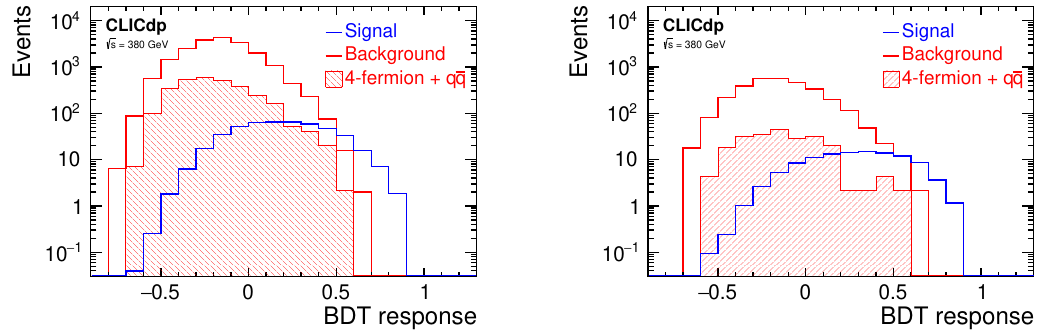
Figure 29. Response distribution of the BDT classi(cid:12)er used for the (cid:12)nal t ! cH event selection at p s = 380 GeV, for hadronic (left) and semi-leptonic (right) event samples. The total background (red histogram) is normalised to 1.0 ab (cid:0) 1 while the signal (events with a FCNC top quark decay; blue histogram) is normalised to BR(t ! cH) (cid:2) BR(H ! bb) = 10 (cid:0) 3 . The hatched histogram indicates the contribution from four fermion and quark-pair